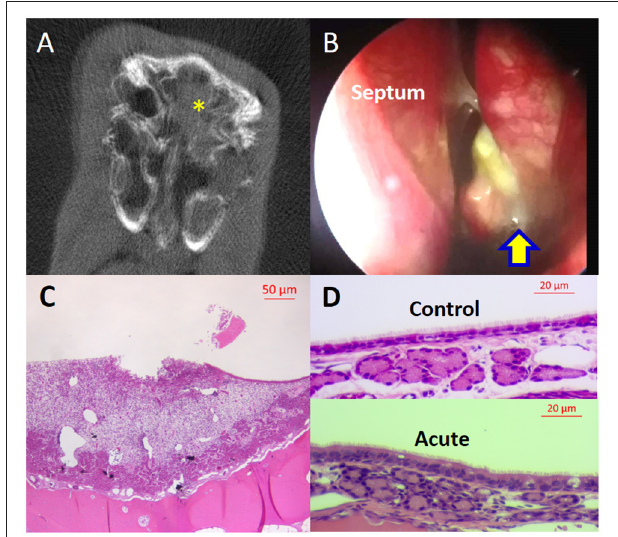
FIGURE 2 | Rabbit model of acute sinusitis (Week 2). (A) MicroCT—Full opacification (yellow asterisk) of left sinuses. (B) Nasal endoscopic examination—significant purulent drainage from left middle meatus (yellow arrow). (C) Histology—superficial mucosal ulceration with infiltration of neutrophils, subepithelial edema, and epithelial hypertrophy (scale bar upper right). (D) Histology—upper panel: normal sinus epithelium; lower panel: significant infiltration of inflammatory cells in the epithelium and subepithelial space (scale bar upper